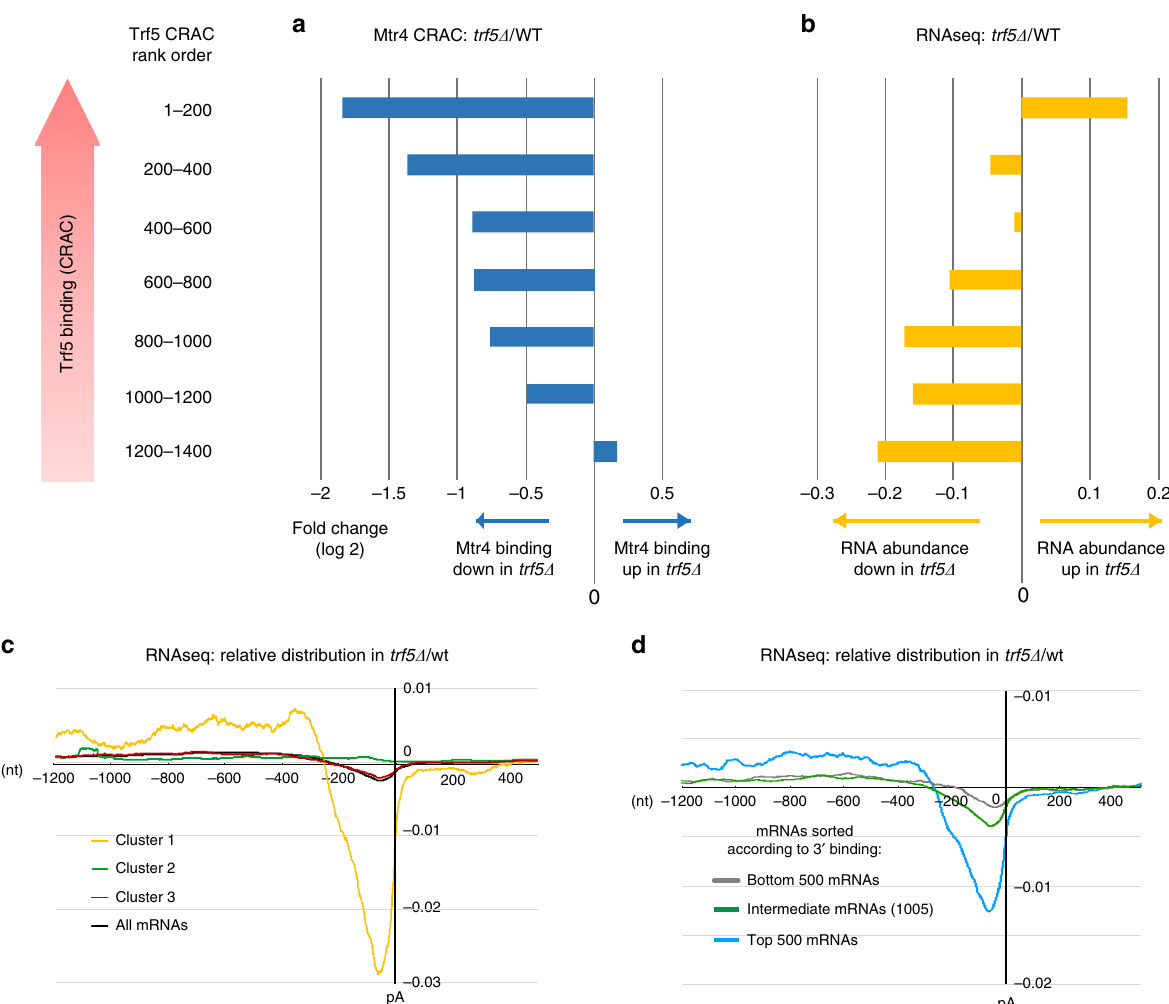
Fig. 7 Alterations in mRNA abundance in strains lacking Trf5. a Changes in Mtr4 binding by CRAC in strains lacking Trf5, relative to the wild type. b Changes in mRNA abundance by RNAseq in strains lacking Trf5, relative to the wild type. Genes are ordered by ranking in frequency of Trf5 binding (RPKM) and bars show fold change (log 2) in strains lacking Trf5 relative to the wild type. Note that these are normalized data, so the total recovery of Mtr4 across all genes is constant. c , d RNAseq distribution across mRNAs, normalized to the total binding value across the mRNA subset, in wild-type (four independent replicates averaged) and trf5 Δ (three independent replicates averaged). Reads were aligned with the polyadenylation sites (pA). c shows genes grouped according to clusters identi fi ed in Fig. 5a, plus all mRNAs. In d , the 2005 genes analyzed in Fig. 5 are grouped by Trf5 binding in the 3 ′ region (bin 5 in Fig. 5a and Supplementary Fig.